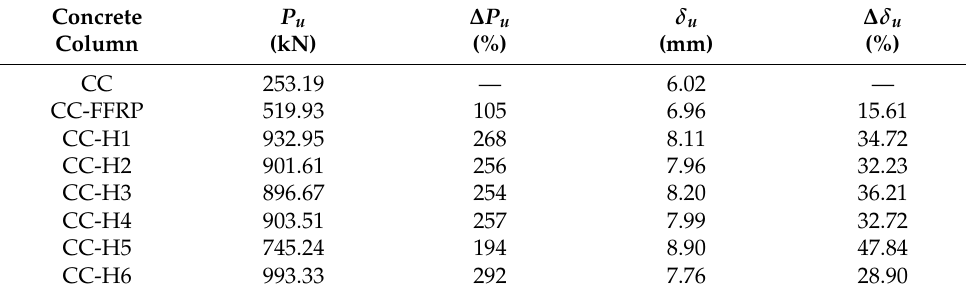
Figure 5. Load–displacement curves of concrete cylinders under unconstrained and diverse constraint conditions. Table 5. Characteristic loads of concrete columns under different